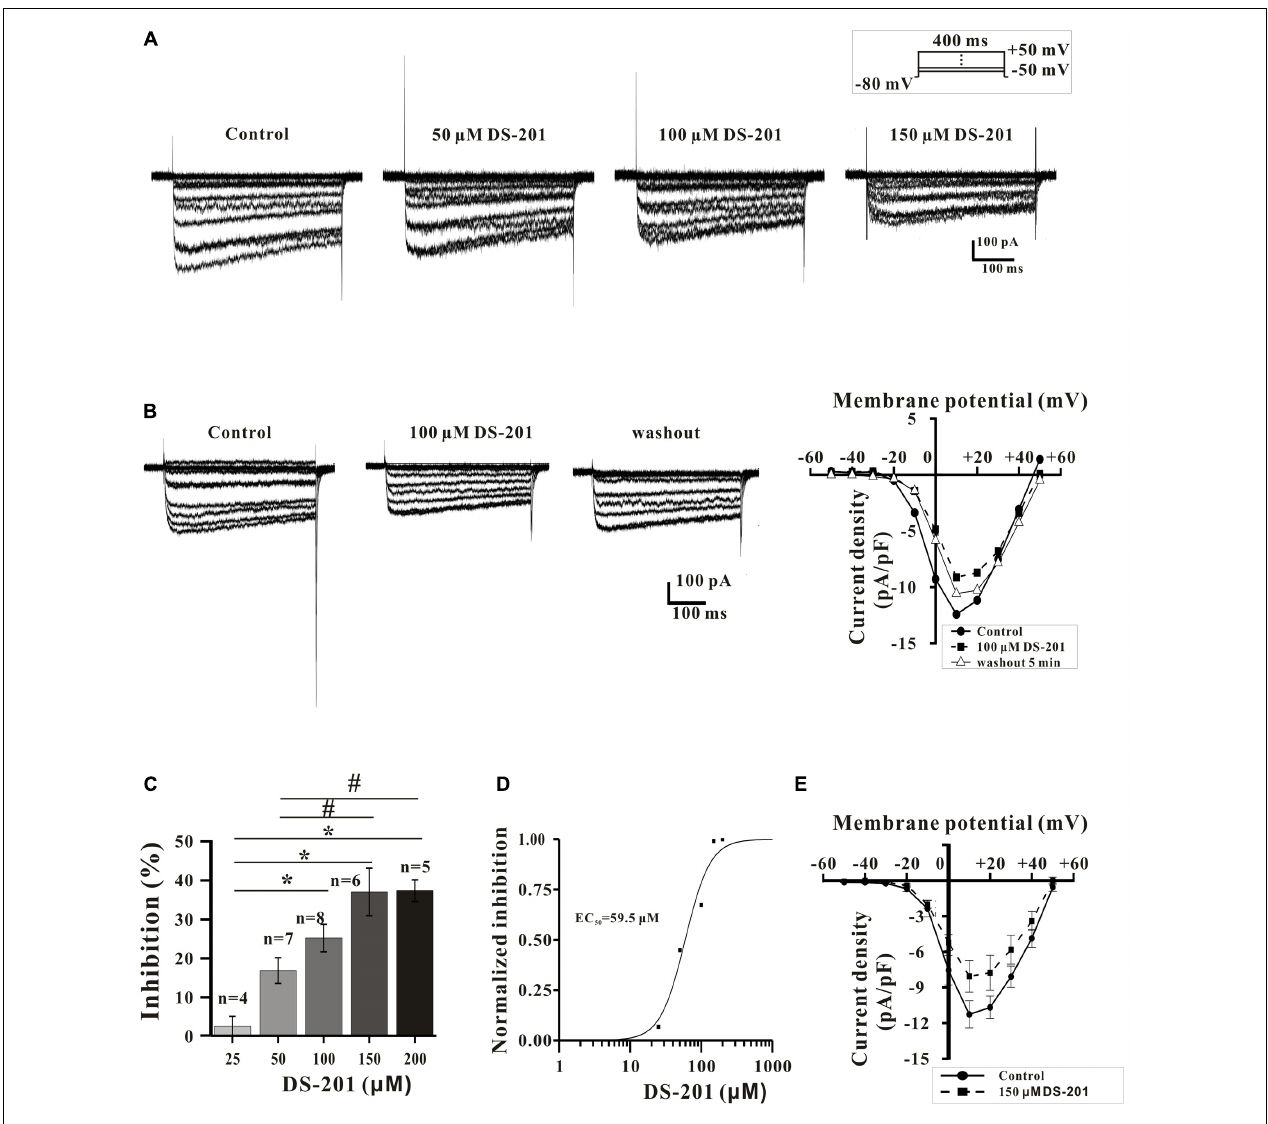
FIGURE 6 | Effect of DS-201 on L-type Ca 2 + channel in L Ca channel-transfected HEK293 cells. (A) I Ca , L was inhibited by DS-201 (50, 100, and 150 µ M) in a concentration-dependent manner. (B) The inhibition of I Ca , L induced by DS-201(100 µ M) was partially reversible. (C) Histograms show that the inhibition of peak Ca 2 + currents by DS-201 (25–200 µ M) was concentration dependent measured at + 10 mV membrane potential. (D) Concentration-response curves of DS-201 fitted with Hill function. The Data were panel C . Hill function: [Inhibition % = X n /( k n + X n )], X as the concentration of DS-201, K as the Michaelis constant (i.e., EC50), and n as the Cooperative sites. (E) Effect of DS-201 on the I-V relationship of I Ca , L . Data obtained from 6 cells showing that 150 µ M DS-201 inhibited the peak current, but did not change the relationship including maximum activated potential and reversal potential. The data were obtained from the average of eight experiments with 4–8 cells in one